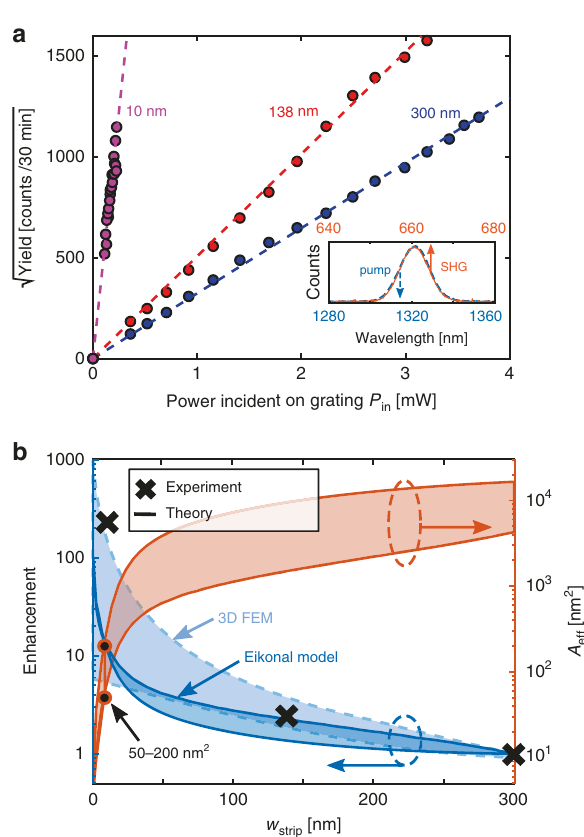
Fig. 6 Experimental demonstration of nanoscale intensity enhancement in the HPIC. a Circles: square root of the measured yield for each sample (color coding as in Fig. 5). Dashed lines: linear fi ts con fi rming quadratic / P dependence on incident power ( I 1 = 2 ). Inset: spectra of the pump in SHG (blue), and of the SHG from the tip (orange). b Calculated enhancement (left axis, solid line) and effective area (right axis, dashed line) as a function of strip width for a focuser length of 3 μ m, relative to the largest w strip = 300 nm, following 38 . Light- and dark-blue shadow encompass the enhancement values predicted by full 3D simulations and the Eikonal model respectively, see Supplementary Fig. 5b. Black crosses show the experimentally measured relative increase in intensity, obtained from the square of the slopes in ( a ) — error bars from con fi dence intervals of the straight line fi ts in ( a ) are smaller than symbol size. Black circles: calculated effective area range of 50 – 200 nm 2 for w strip = 10